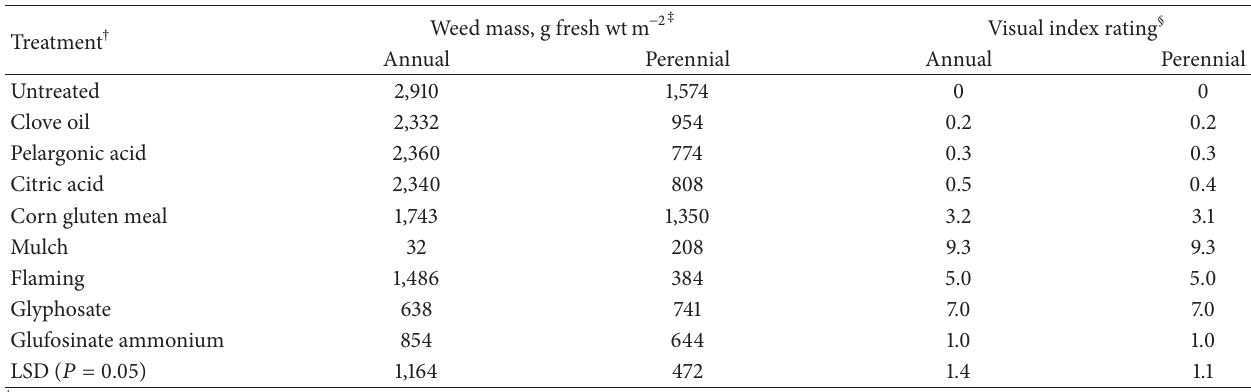
Table 6: End-of-season weed mass and visual indexing of treatments with alternative herbicides, mulches, burning, or conventional herbicides in field plot research with annual and perennial vegetation (Field Experiment